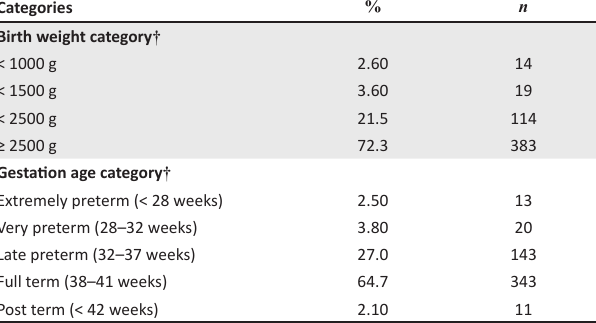
TABLE 3: Distribution of birth weight and gestation age ( N =